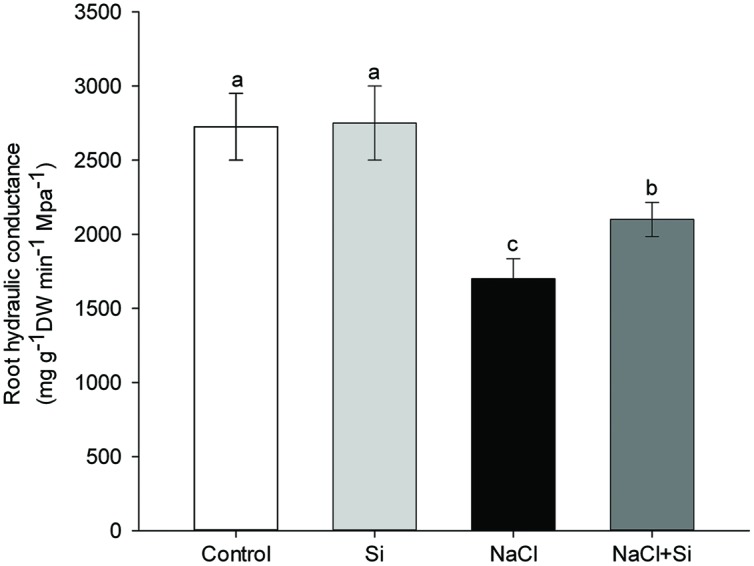
Effects of silicon (0.83 mM) and salt stress (65 mM) on root hydraulic conductance (Lp). The Lp was measured after 7.5 days of salt treatment. Vertical bars represent the standard deviations (n = 3). Different letters represent significant differences (p <0.05) between the treatments.